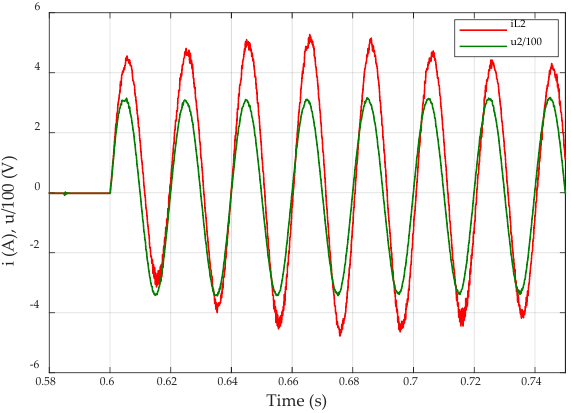
Figure 10. Detail of voltage and current transient in the converter output of prosumer 2.